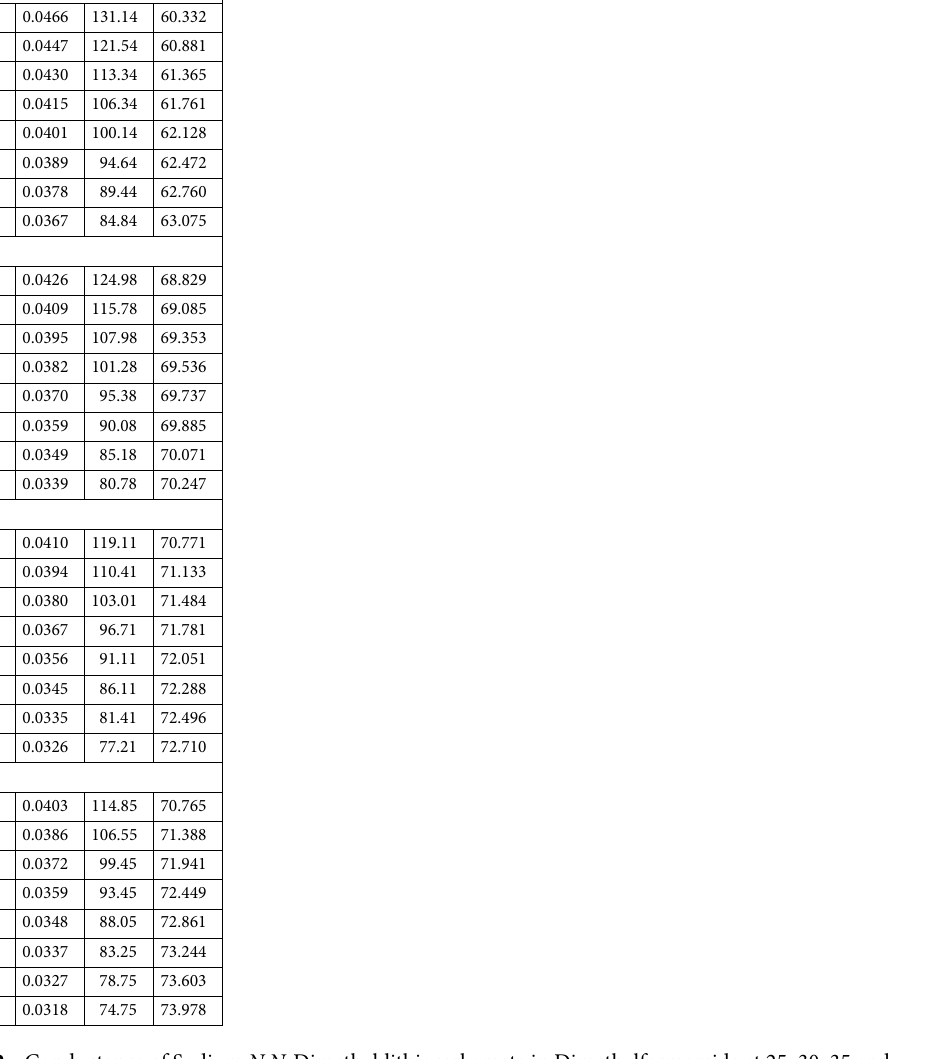
Table 2. Conductance of Sodium N , N -Dimethyldithiocarbamate in Dimethylformamide at 25, 30, 35 and 40 °C and 1